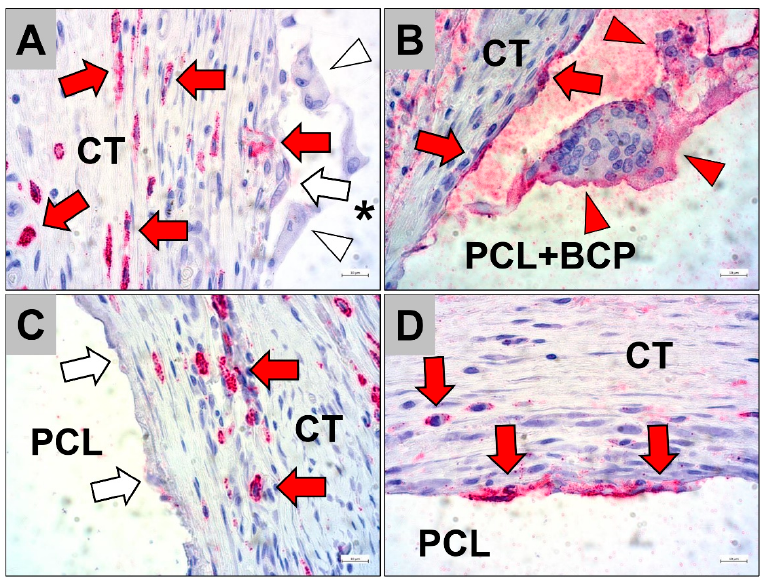
Figure 5. Representative images of the inflammatory tissue reactions to the scaffolds within the subcutaneous connective tissue (CT) at day 15 post implantationem. ( A ) CD163 detection and ( B ) CD11c detection within the implantation beds of the PCL scaffolds combined with the BCP granules (PCL+BCP and asterisk in ( A )). ( C ) CD163 detection and ( D ) CD11c detection within the implantation beds of the pure PCL scaffolds. Red arrows = positive macrophages, white arrows = negative macrophages, red arrowheads = positive multinucleated giant cells, white arrowheads = negative multinucleated giant cells (immunostainings, 400 × magnifications, scalebars = 10 µ